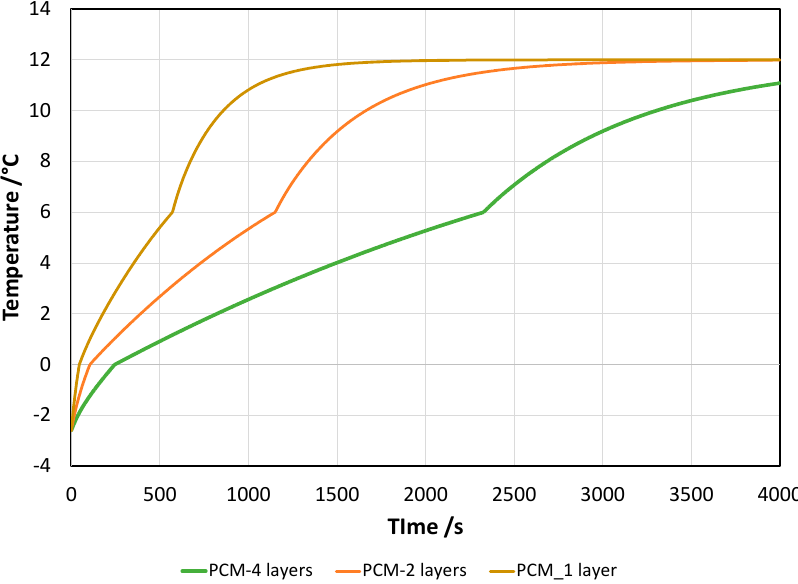
Figure 9. Average PCM temperature for different numbers of stacked PCM layers during discharge. HTF flow rate 0.5 kg/s, HTF inlet 12 °C.